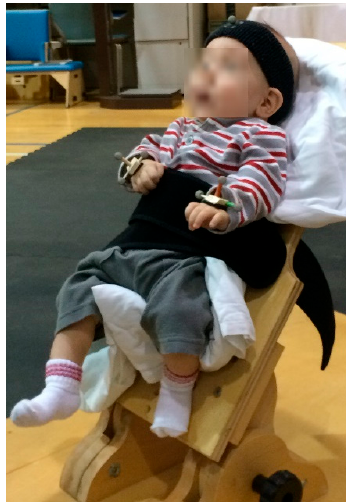
Figure 1. Infant seated in the custom chair and wearing retroreflective markers for 3D motion capture.